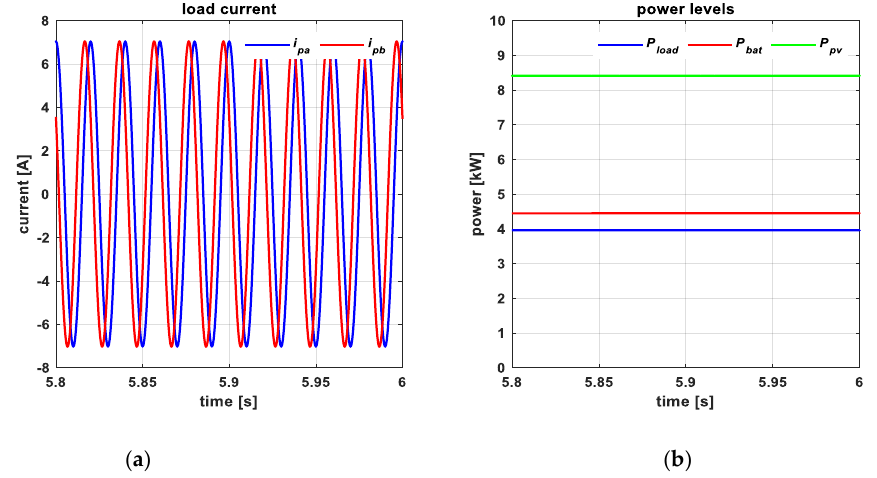
Figure 13. Steady-state behavior of load currents: ( a ) and of power ( b ); load power (blue line), PV power (green line), and battery power (red line).